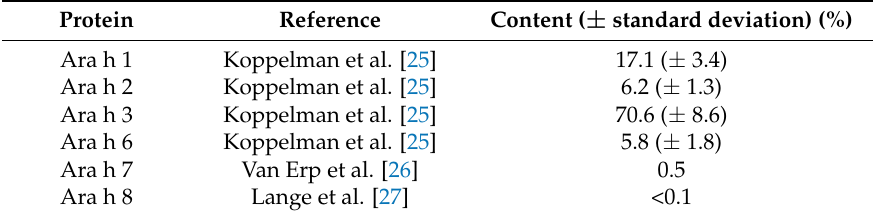
Table 2. Percentage of total protein content of individual peanut allergens.